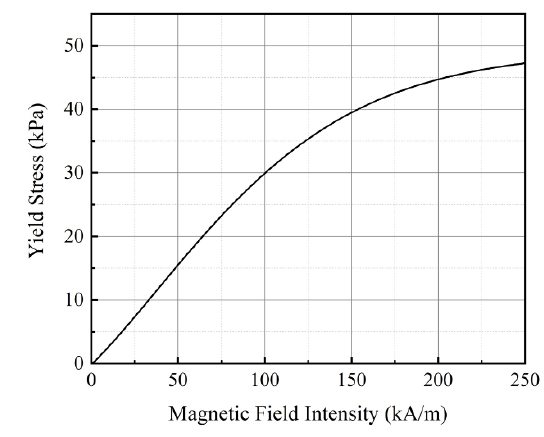
Figure 7. Magnetic field-dependent yield stress of MR fluid.